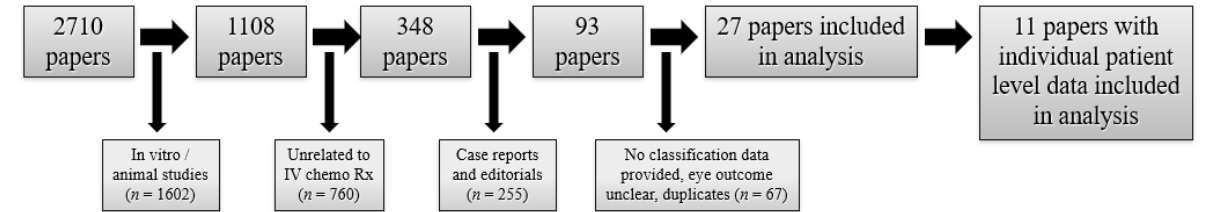
Figure 1. Study inclusion/exclusion algorithm. Studies were excluded if they involved in vitro or animals ( n = 1602), used a treatment modality other than IV chemotherapy ( n = 760), were small case series or editorials ( n = 255) or had no disease classification data or unclear outcomes ( n = 67). Table 1. Characteristics of studies included in